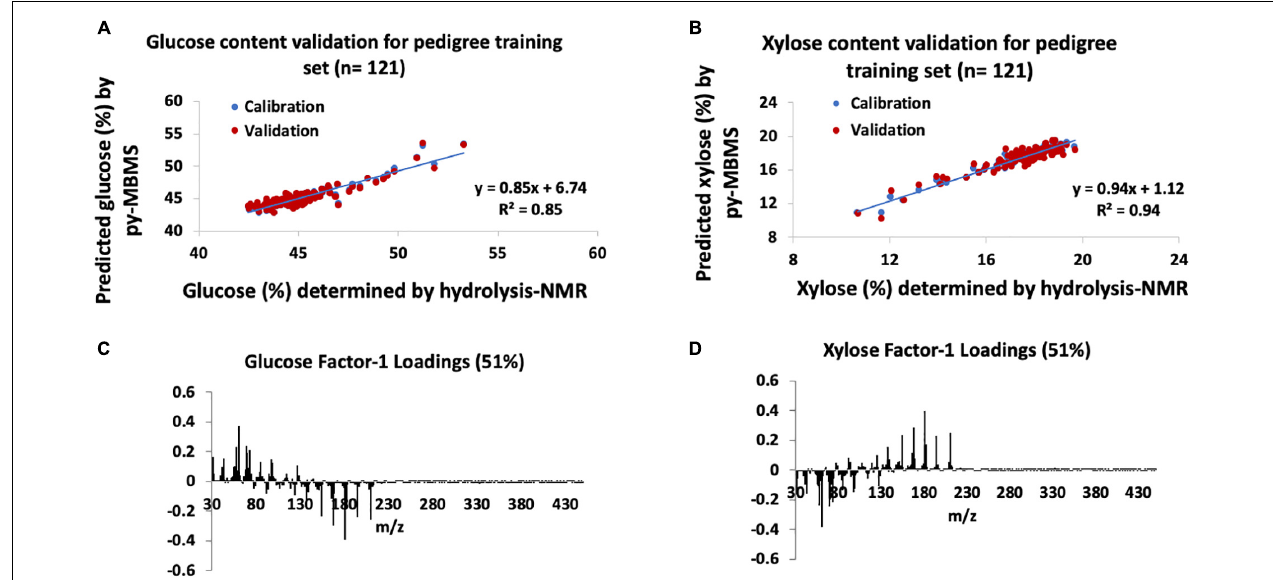
FIGURE 3 | Models for glucose and xylose content estimates in pedigrees of P. trichocarpa . (A) Glucose content validation for pedigree training set, (B) xylose content validation for pedigree training set, (C) factor-1 spectral loadings for pedigree glucose model, and (D) factor-1 spectral loadings for pedigree xylose model.